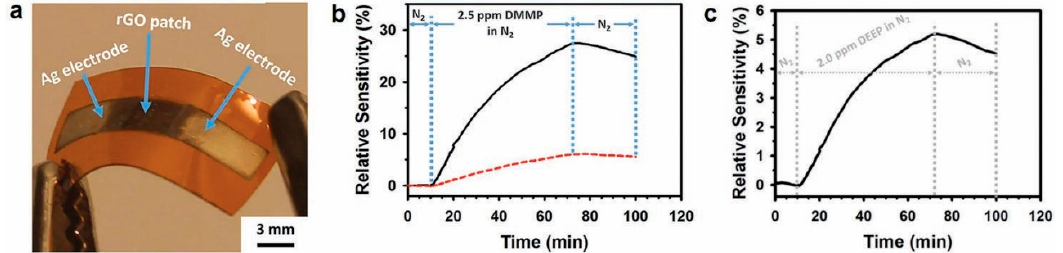
Figure 4. ( a ) Flexible gas sensor, with inkjet-printed reduced graphene oxide (rGO) and silver (Ag) electrodes on treated Kapton. ( b , c ) Relative sensitivity response to DMMP and DEEP in N 2 gas at room temperature [86,87]. Reproduced with permission from Spring Nature and Royal Society of Chemistry.